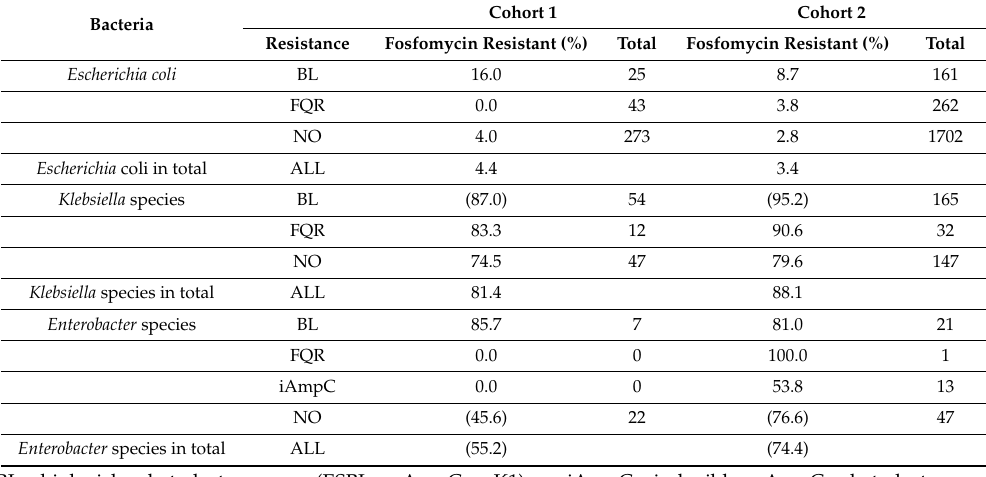
Table 2. Resistance levels of the most frequent Gram-negative bacteria from urine samples to fosfomycin before (Cohort 1) and after (Cohort 2) fosfomycin registration. Brackets indicate statistically significant di ff erences ( p < 0.05) between Cohort 1 and Cohort